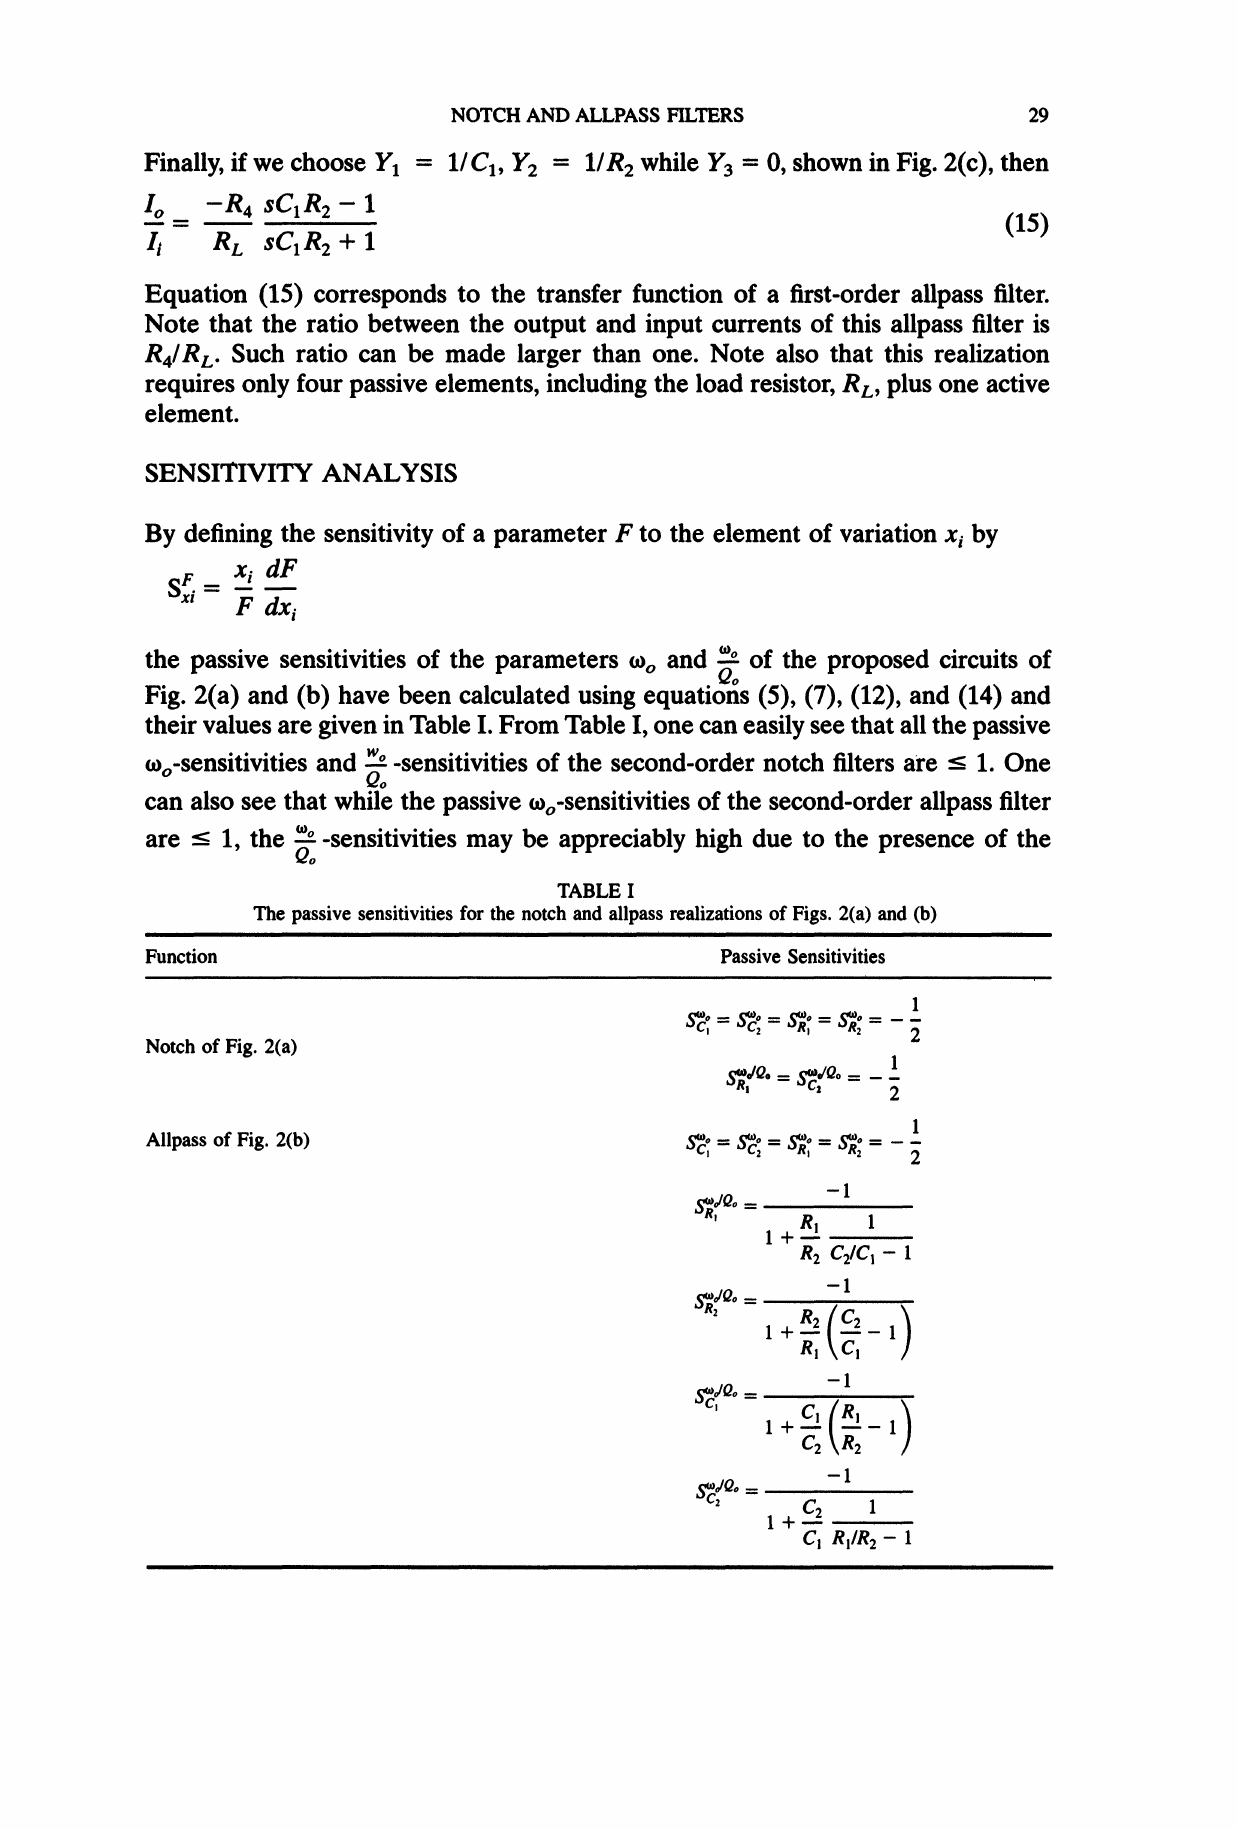
Notch of Fig. 2(a)